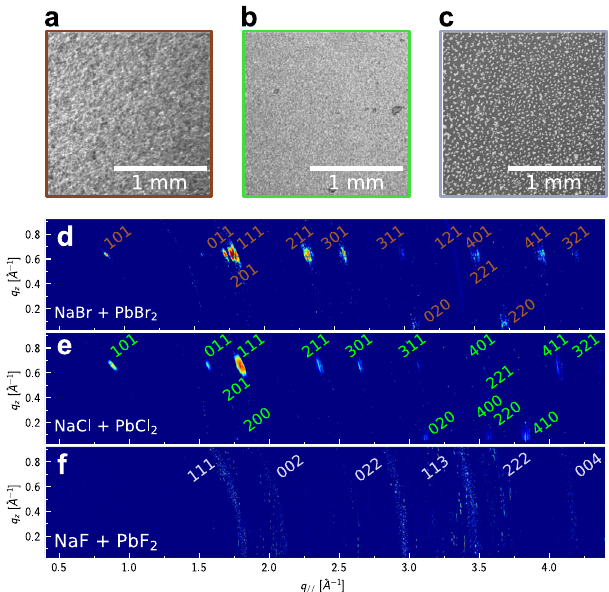
Fig. 4 | Structure of the bulk Hg halide fi lm. a – c Optical microscopy images and d – f X-rayintensitymapsofthedepositsonHgelectrodesformedby1hdeposition at − 0.60V in 0.01M NaX+0.25mM PbX 2 with X being a , d Br, b , e Cl, and c , f F, respectively. The GID data were measured at incidence angles of 0.122° and transformed into the reciprocal space coordinates q z and q // . All the experiments were recorded after 1h deposition at − 0.60V.The millerindexes of the diffraction peaksfortheidenti fi edcompounds d Pb(OH)Br, e Pb(OH)Cl,and f PbF 2 aregivenin the